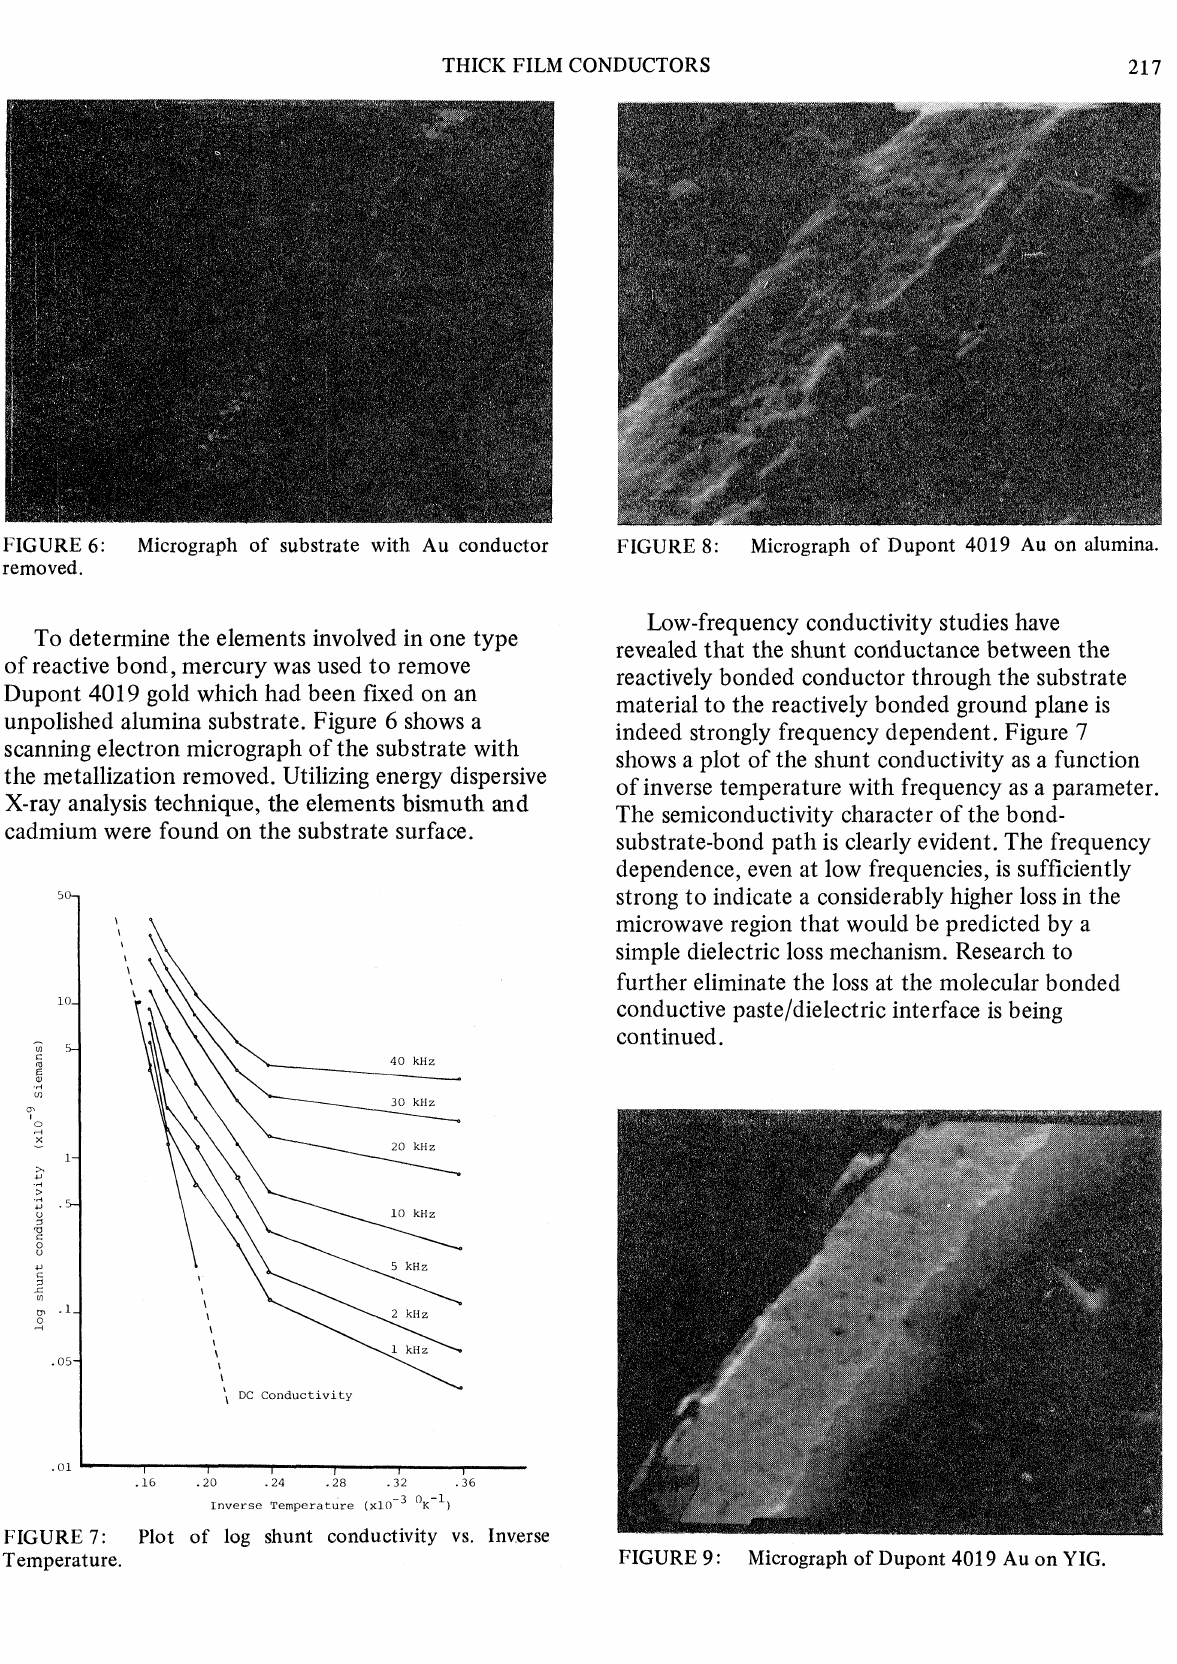
Micrograph of Dupont 4019 Au on